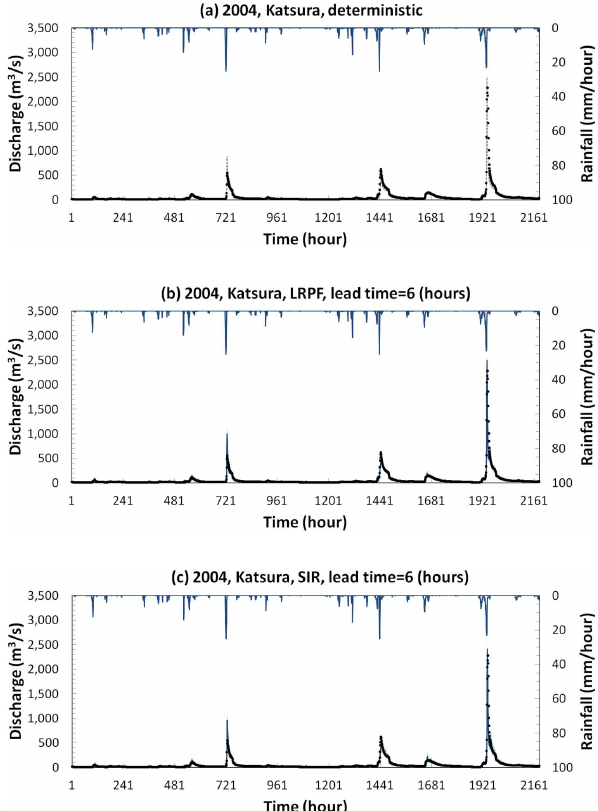
Fig. 8. Observed versus 6-h-lead forecasts at the Katsura station via LRPF and SIR (1 August–30 October 2004): (a) a deterministic modelling case; (b) LRPF; and (c) SIR. The blue line and area rep- resent the mean value and 90% confidential intervals, respectively. A gray dashed line represents a deterministic modelling case. The black dots represent observed